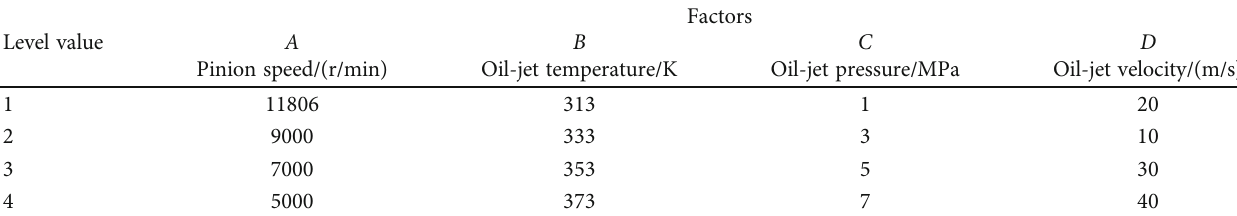
Table 5: Factor level.